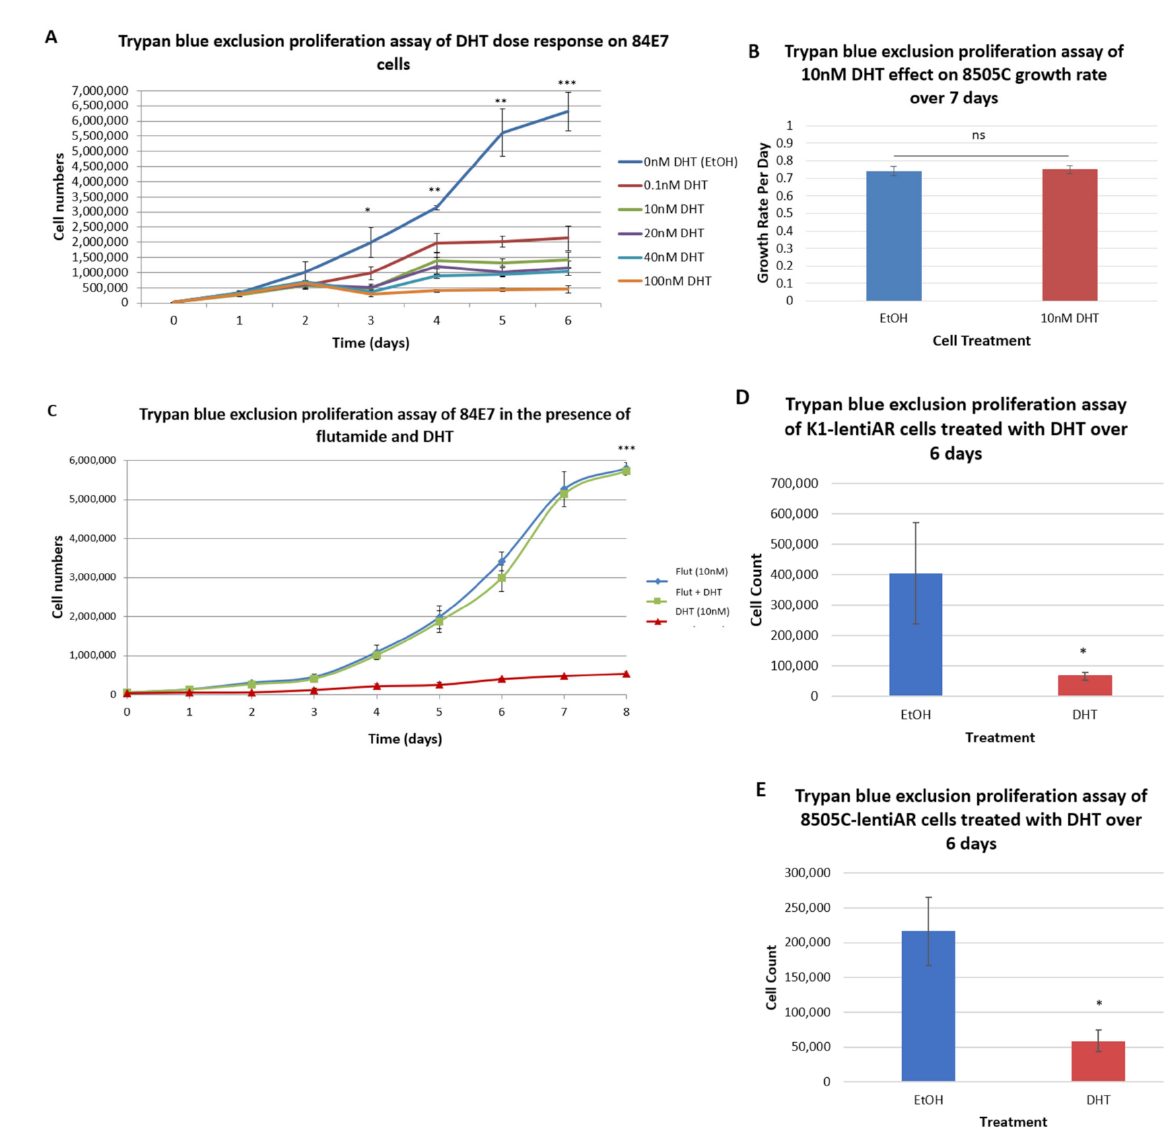
Figure 2. Effect of AR activation on cell proliferation: ( A ) Prolonged AR activation reduced androgen-responsive 84E7 cell growth in a concentration-dependent manner. ( B ) Parental androgen- unresponsive 8505C cells continued to proliferate at the same rate upon prolonged AR activation. ( C ) In the presence of both flutamide and DHT, 84E7 cells continued to proliferate and reach con- fluency. ( D ) AR activation reduced proliferation in lentivirus-induced androgen-responsive thy- roid cancer cell line, 8505C-lentiAR. ( E ) AR activation reduced proliferation in lentivirus-induced androgen-responsive thyroid cancer cell line, K1-lentiAR. Data are expressed as raw numbers ob- tained from cell counts, and the asterisks denote statistically significant differences (* p -value < 0.05, ** p -value < 0.005, *** p -value <